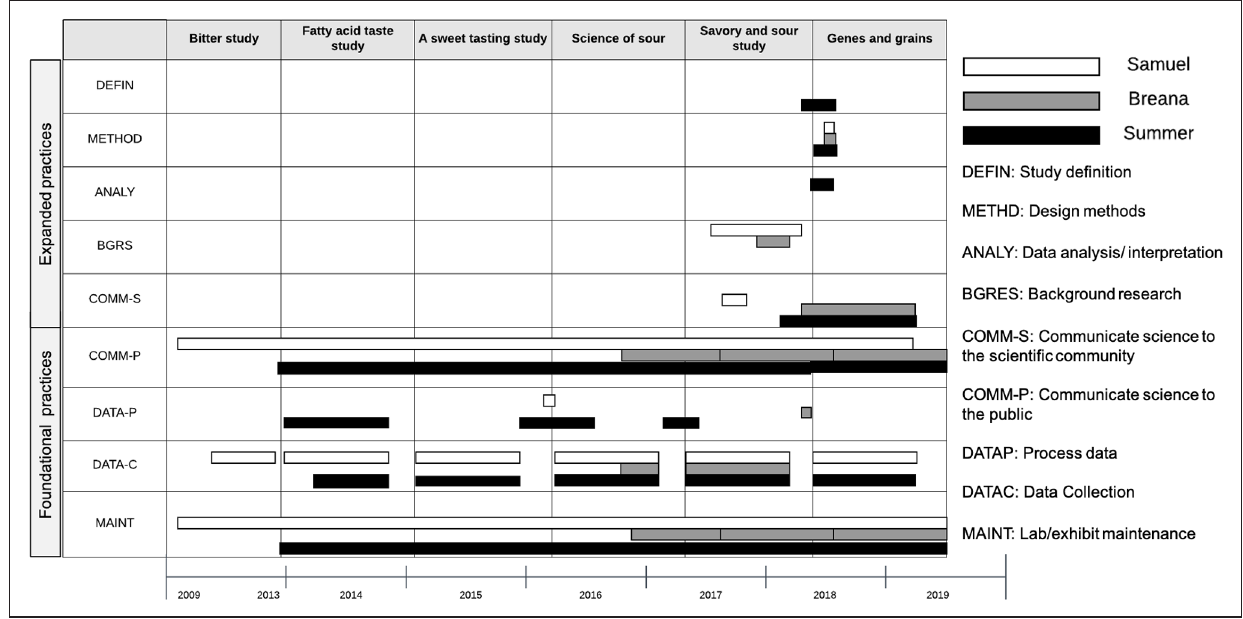
Figure 2 Participation in practices among focal participants. Three individual case studies (Samuel, Breana, and Summer) indicate the types of practices participants engaged in over the course of six genetics studies. The scientific practices with examples are shown in Table 2, and a summary of the participation frequency across all scientists is in Figure